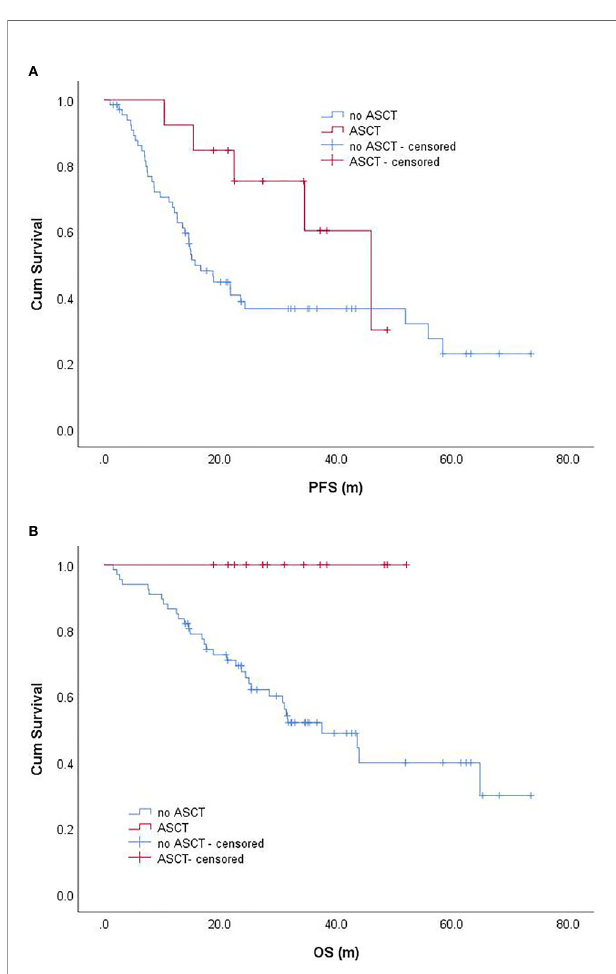
FIGURE 3 | Progression-free survival (A) and overall survival (B) of EMM patients with and withoutASCT. progression-freesurvival;OS, overall